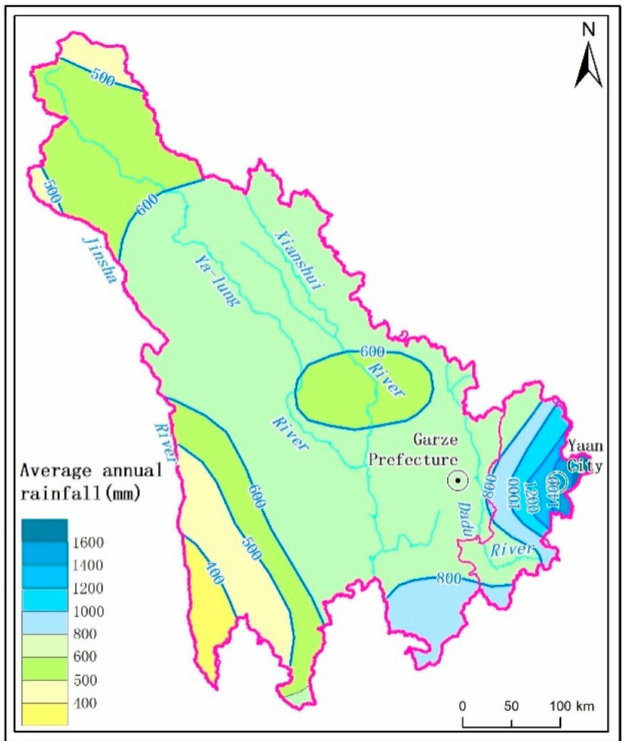
Figure 3. Rainfall distribution map in the study